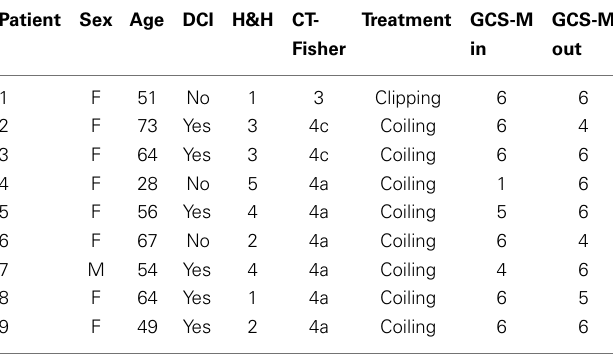
Table 1 | Patient demographics and clinical characteristics of nine SAH patients